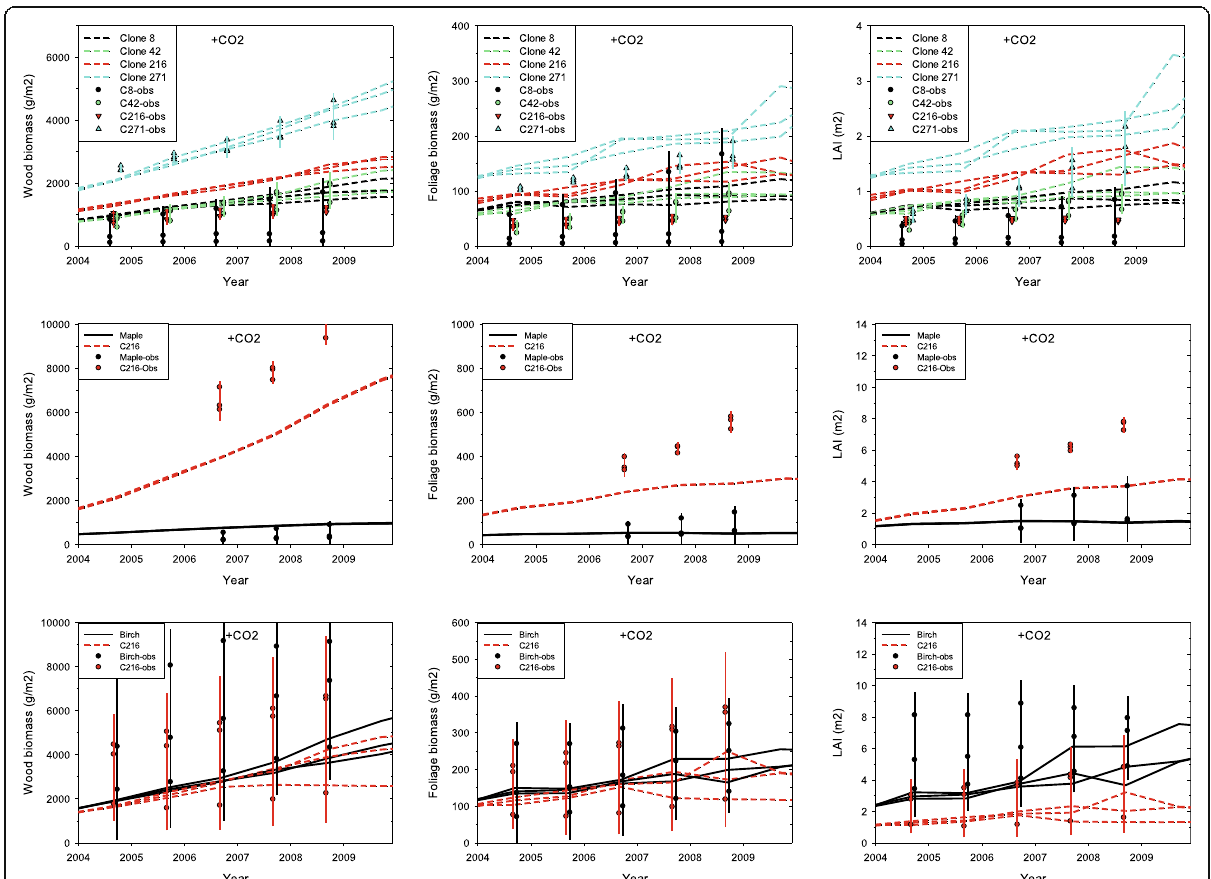
Fig. 2 Comparison of modeled values (dashed lines show each replicate) with empirical observations (symbols) of mid-summer values under elevated CO 2 (+CO2) conditions. Symbols and 95% confidence intervals (vertical solid lines) are offset to enhance visual clarity ( N =